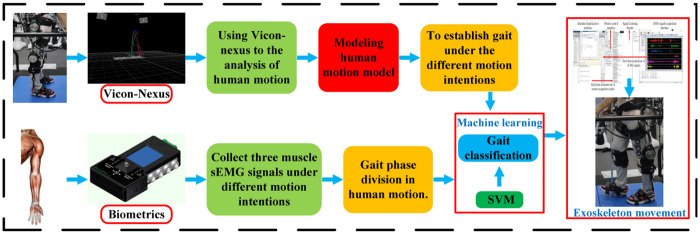
The main flowchart.